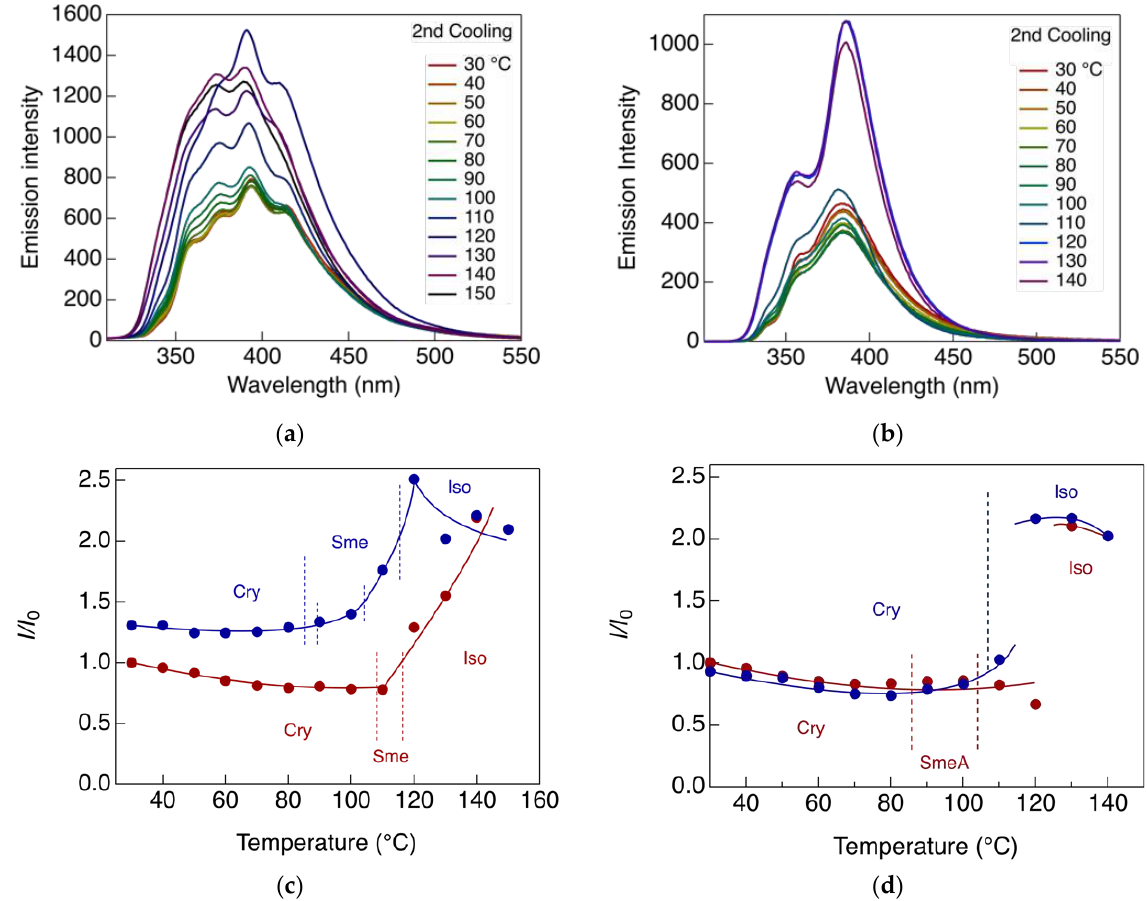
Figure 7. Photoluminescence behavior of biphenylacetylene compounds at various temperatures. Photoluminescence spectra of ( a ) 5-BPTMS and ( b ) 6-BPTMS at various temperatures during the 2nd cooling process ( λ ex = 296 nm). Relative emission intensity ( I / I 0 , where I 0 is the intensity at 30 °C during the heating process) of ( c ) 5-BPTMS and ( d ) 6-BPTMS at 391 nm as a function of temperature (red, 2nd heating scan; blue, 2nd cooling scan).